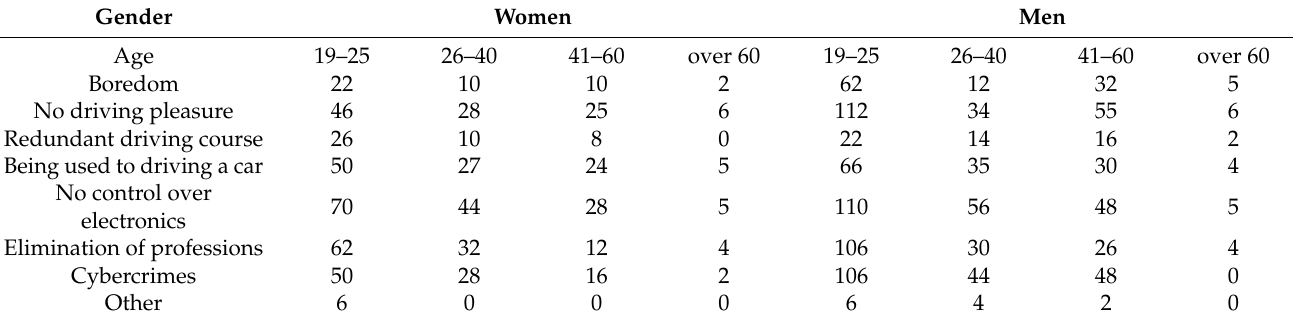
Table 2. Potential disadvantages of the AV concept in the opinion of women and men.